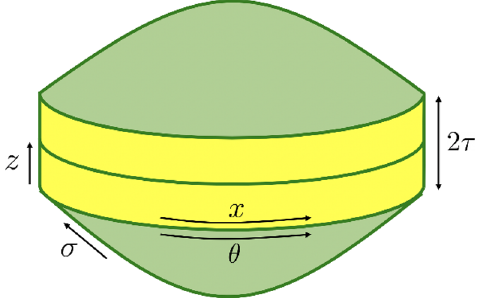
Figure 8 . We can have a disconnected solution whose gravity region involves two disks.